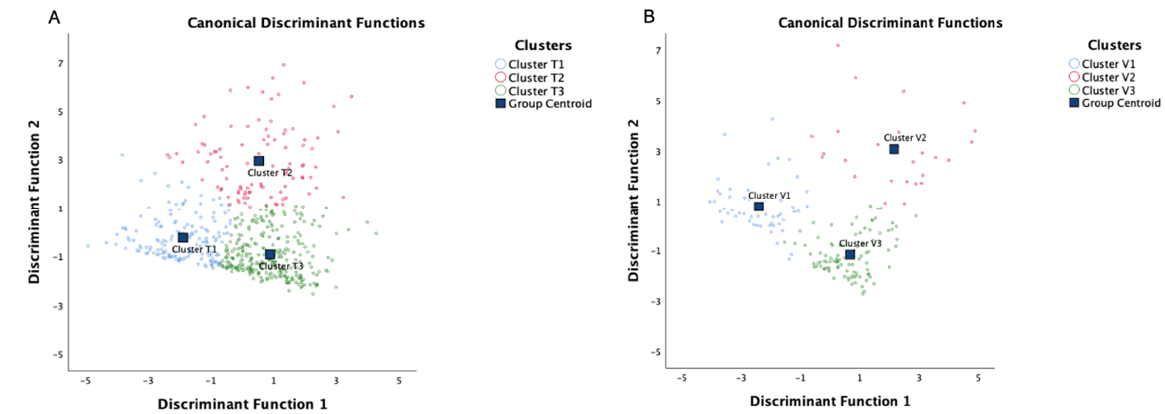
Figure 4. Canonical discriminant function analysis of the patient in ( A ) the training set and ( B ) the validation set. By using a stepwise method of discriminant analysis, three clusters were separated in the two sets. Cluster T, clusters identified in the training set; Cluster V, clusters identified in the validation set.